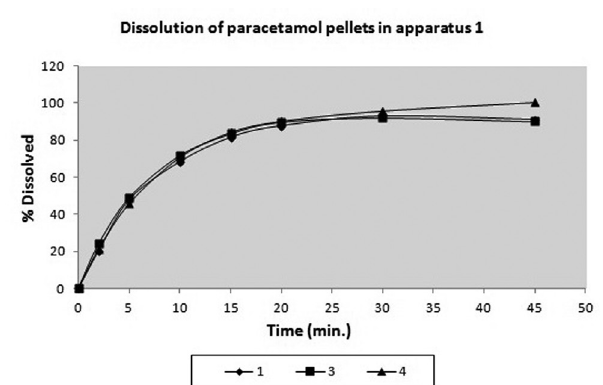
FIGURE 5 - Dissolution profiles obtained in apparatus 1 (basket) for formulations 1, 3 and 4. Medium: phosphate buffer pH 5.8.